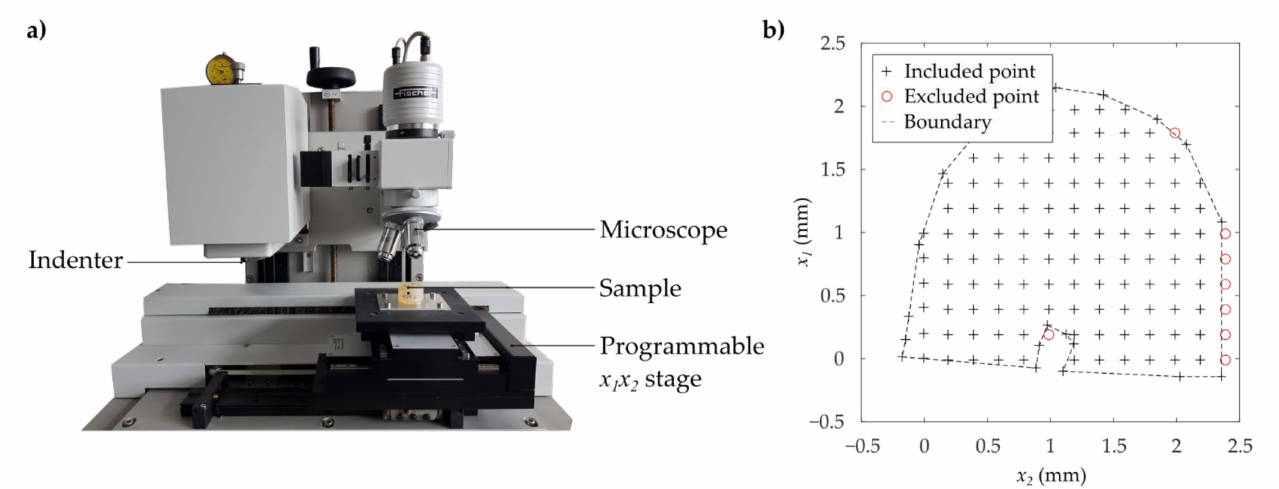
Figure 2. ( a ) Experimental setup and ( b ) example of the applied measuring grid of microindentation